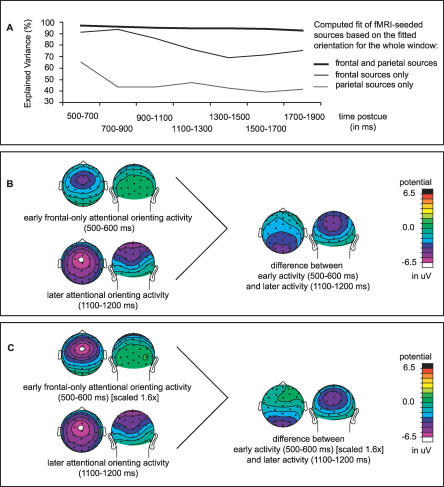
Evidence for Robustness of the Four-Source Frontal-Parietal Model of the Attentional Orienting Activity(A) Explained variance of three different source configurations (frontal only, parietal only, and both frontal and parietal) for the grand-average (n = 13) difference-wave activity between attend and interpret cue responses. These were computed across time (500–1,900 ms) in windows of 200 ms, using the locations and orientations of the sources from the initial fMRI-seeded solution. Note that in the earlier windows, the solution with only two frontal sources (thin black line) explains the variance in the data very well (and better than the solution with only two parietal sources). But later in time, both frontal and parietal sources (thick black line) are needed to explain the data.(B) Topographic distributions of the grand-average (n = 13) attentional-orienting activity at 500–600 ms (upper left map), at 1,100–1,200 ms (lower left map), and the calculated difference between these. Note that the residual activity after the subtraction has a clearly posterior parietal distribution, consistent with a model in which additional posterior sources activate later, rather than a model with only anterior sources that just become more strongly activated over time.(C) Same as (B) but with the attentional-orienting activity between 500–600 ms being scaled in amplitude first, before the subtraction from the activity during the distribution at the later window (i.e., amplitudes at all channels from the early activity were first multiplied by a factor 1.6 to approximately match the amplitude of the midfrontal activity in the later window between 1,100–1,200 ms). Note that the frontal activity is now even more subtracted out, but there still remains clear activity with a posterior parietal maximum.